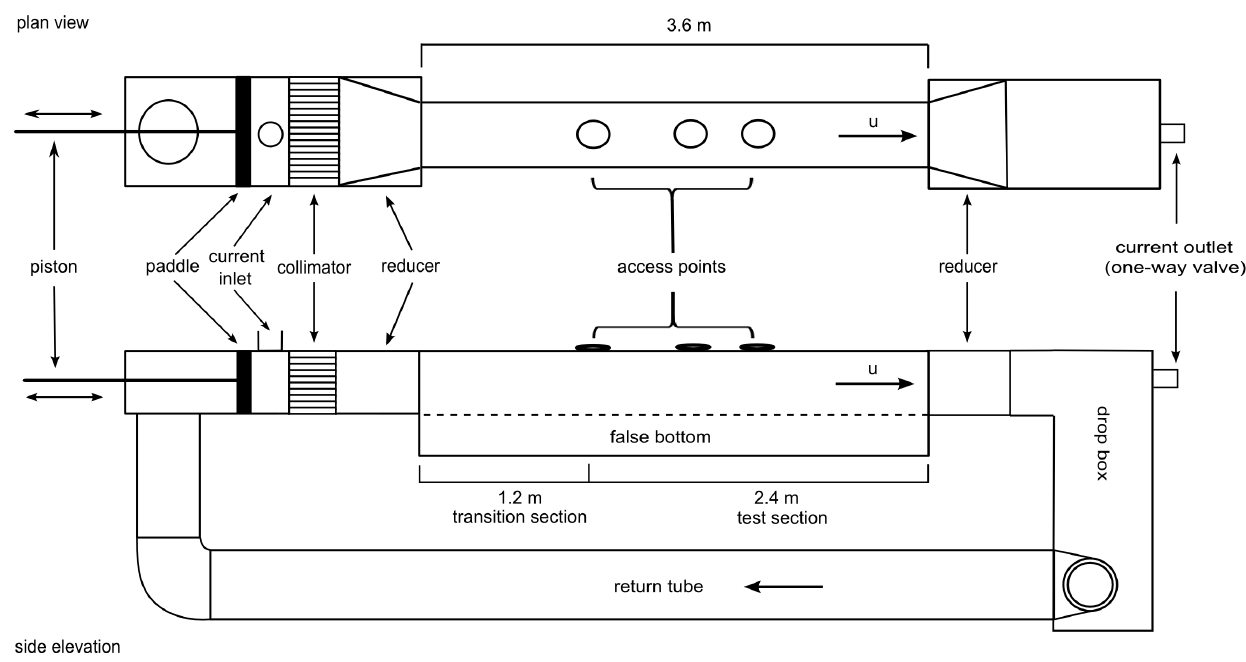
Figure 1. Diagram of the oscillatory water tunnel (OWT). The OWT chamber was used to determine the effects of oscillatory flow on fertilization of the green sea urchin Strongylocentrotus droebachiensis . The drive mechanism that attaches to the paddle (via two coupled hydraulic pistons driven by a flywheel attached to an electric motor powered by an adjustable frequency drive) has been omitted from the figure.